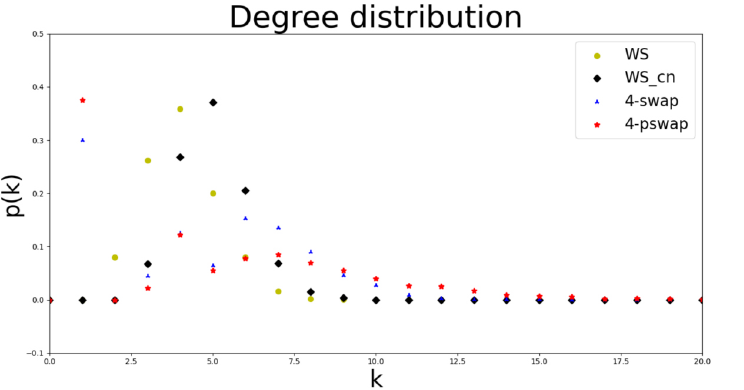
Figure 6. The degree distribution of the network before and after quantum preprocessing. “WS” and “ WS cn ” represent the degree distribution in the original WS network and in the network with the central node, respectively. “ WS 4 swap ” and “ WS 4 pswap ” represent the degree distribution in networks with the central node after 4-swap and 4-pswap,